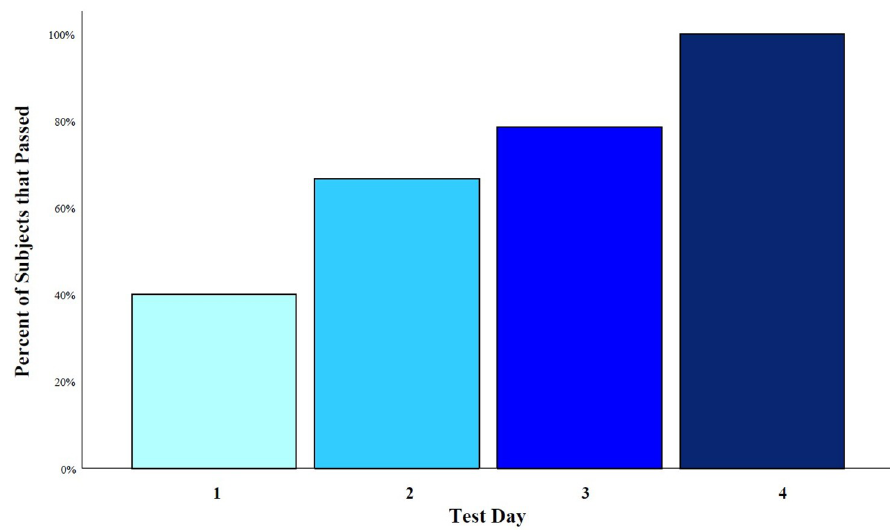
Fig 7. Fit Factor passing rate by test